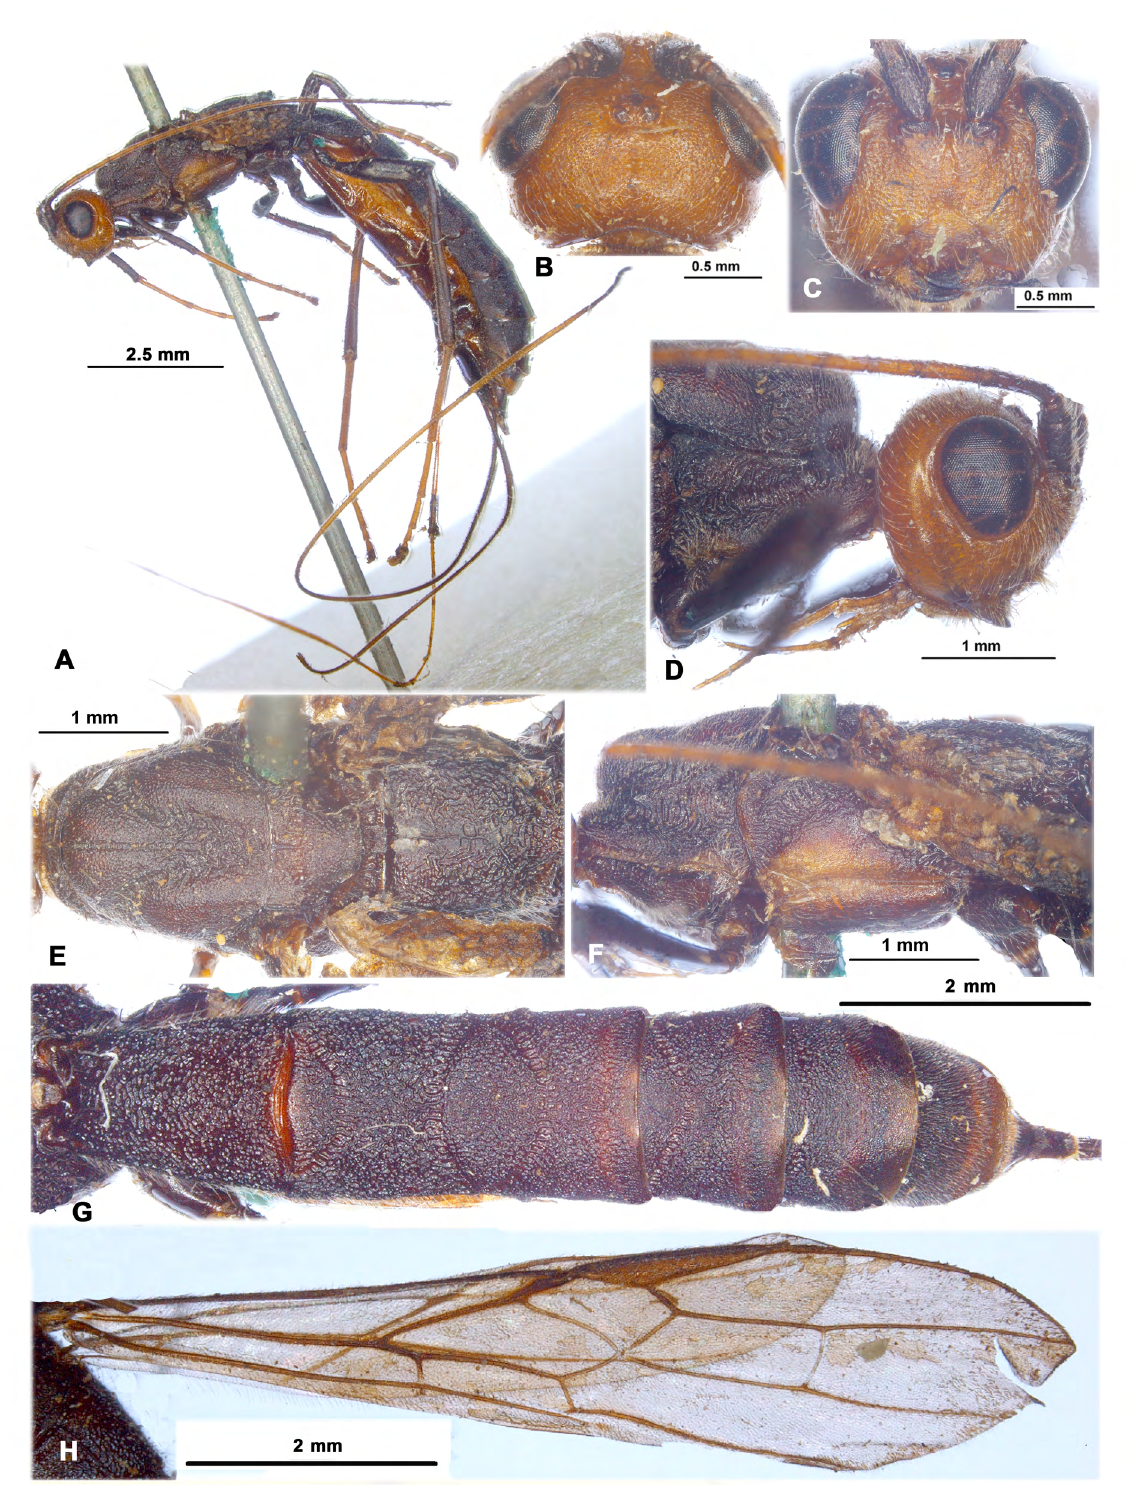
Fig. 5. Bathycentor kraesselini Saussure, 1892, ♀, lectotype, MNHN (A–G); Ipodoryctes parallellus Granger, 1949, ♀, paralectotype, MNHN (H). A . Habitus, lateral view. B . Head, dorsal view. C . Head, front view. D . Head, lateral view. E . Mesosoma, dorsal view. F . Mesosoma, lateral view. G . Metasoma, dorsal view. H .